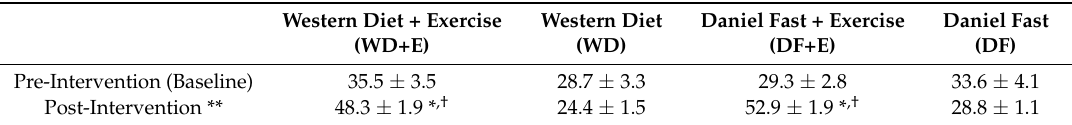
Table 2. Treadmill run time (min) to exhaustion of male rats assigned to two different diets with and without